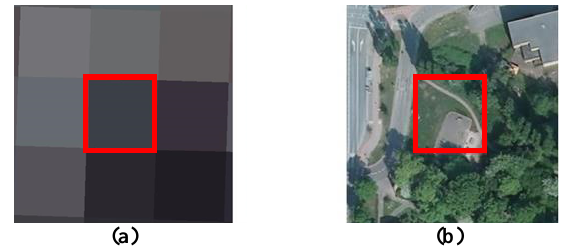
Figure 1 . (a) Greenness of the rectangle: 0.027 & NDVI of the rectangle: 0.052; (b) Visually Measured imperviousness percentage of the rectangle: 35% [Wang n.d.]